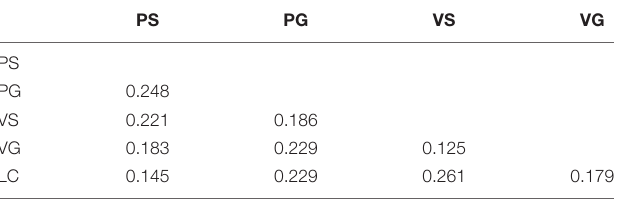
TABLE 3 | Pairwise population PhiPT analysis for Pinus albicaulis